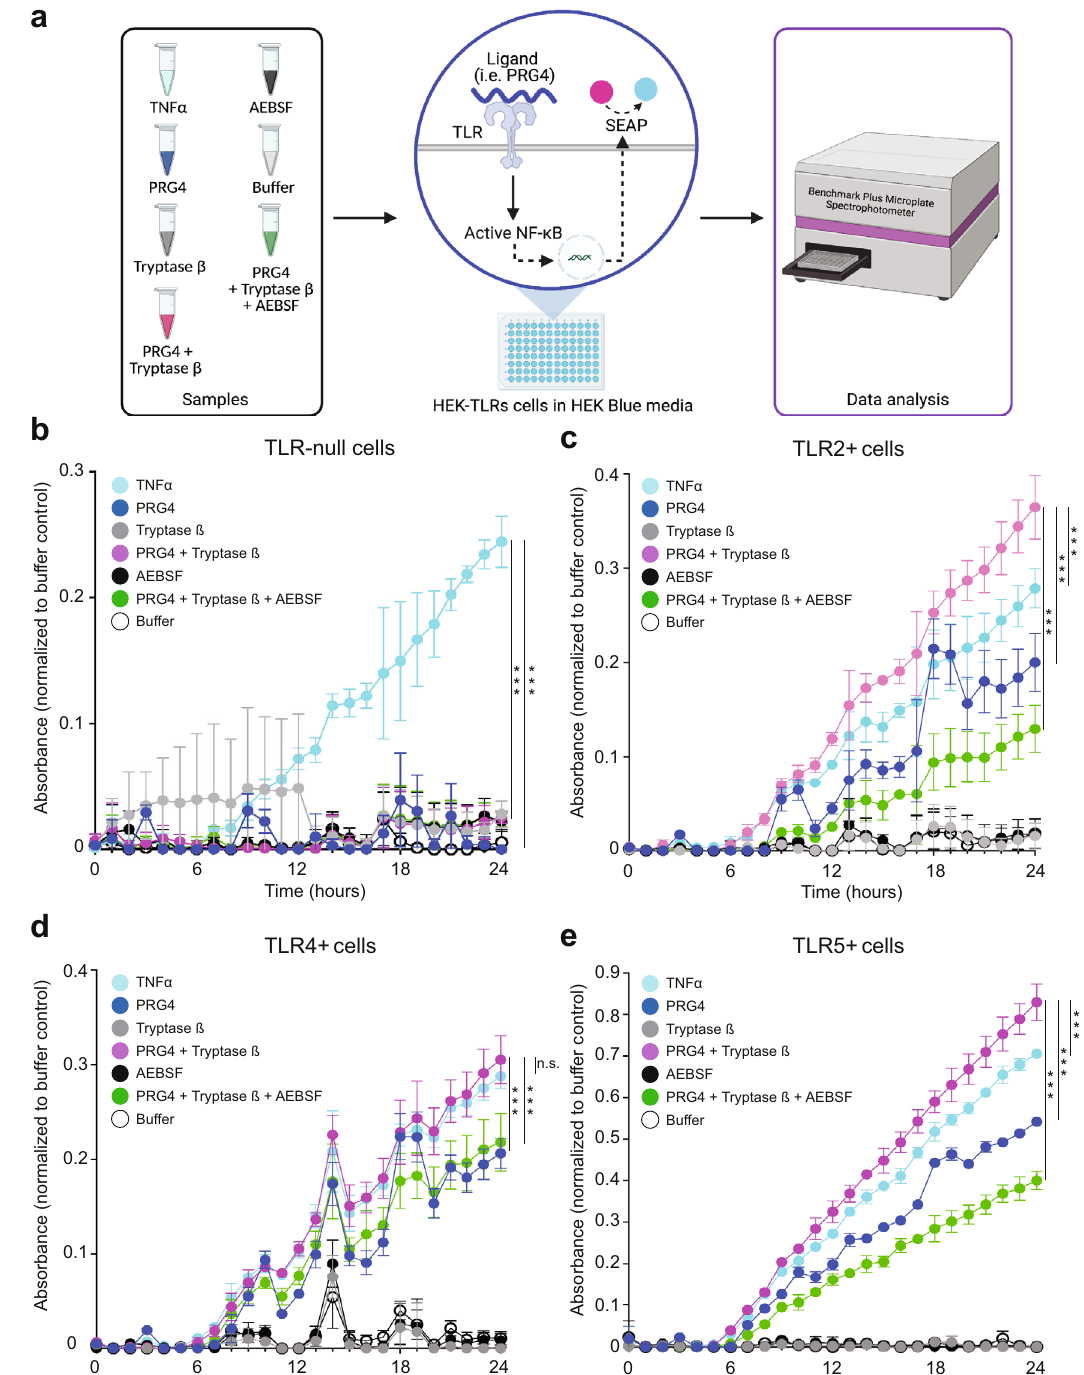
Fig. 4 | NF- κ B activation analysis in HEK-TLR reporter cells. a Schematic of the experimental work fl ow of HEK-TLRS reported cells in HEK Blue media. Recombi- nant human (rh)-PRG4 (blue), rhPRG4 + tryptase β (magenta), tryptase β (dark grey),rhPRG4+tryptase β +AEBSF(green),AEBSF(black),TNF α (paleblue),buffer (light grey) was added to HEK-TLRs cells and monitored over 24h using the